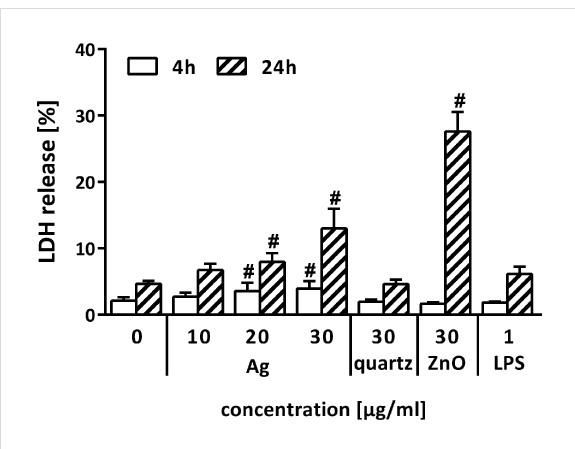
Figure 4: Cytotoxic response of PCLS as measured by LDH release after 4 and 24 h incubation. Results were calculated as percentage of the total LDH content, while Triton X-100 (Triton) lysed PCLS served as positive control with 100% LDH release ( n = 5; # p < 0.05 vs control determined by ANOVA on ranks with post hoc Student–Newman–Keuls test).